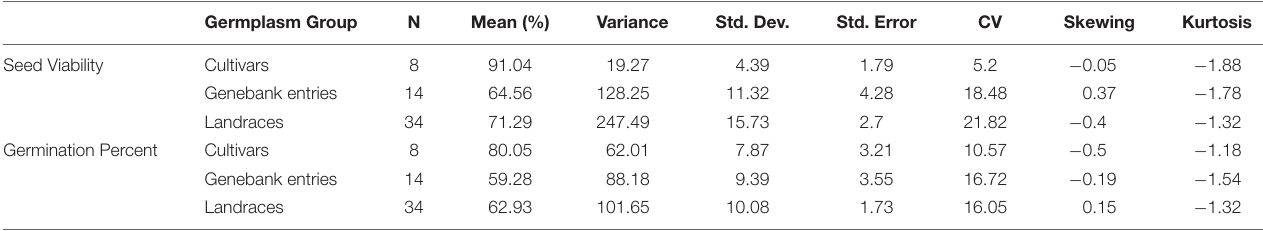
P < 0.01, Based on n = 100 seed per accession.